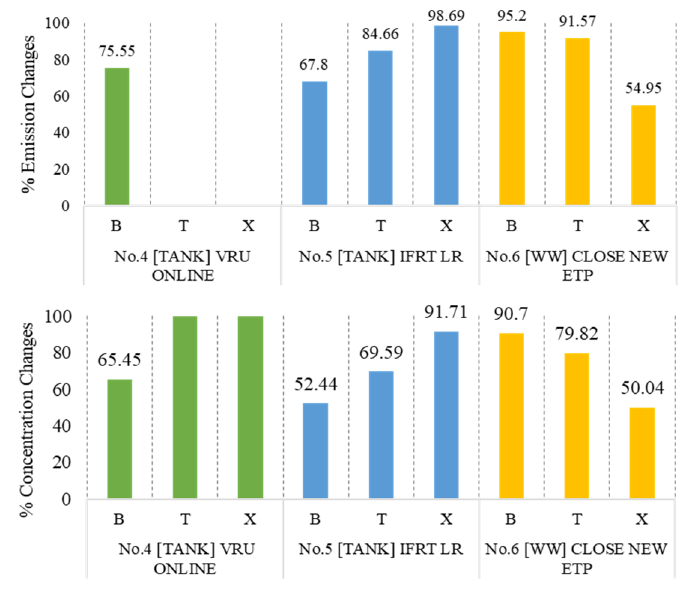
Figure 10. Mitigation measure analysis.